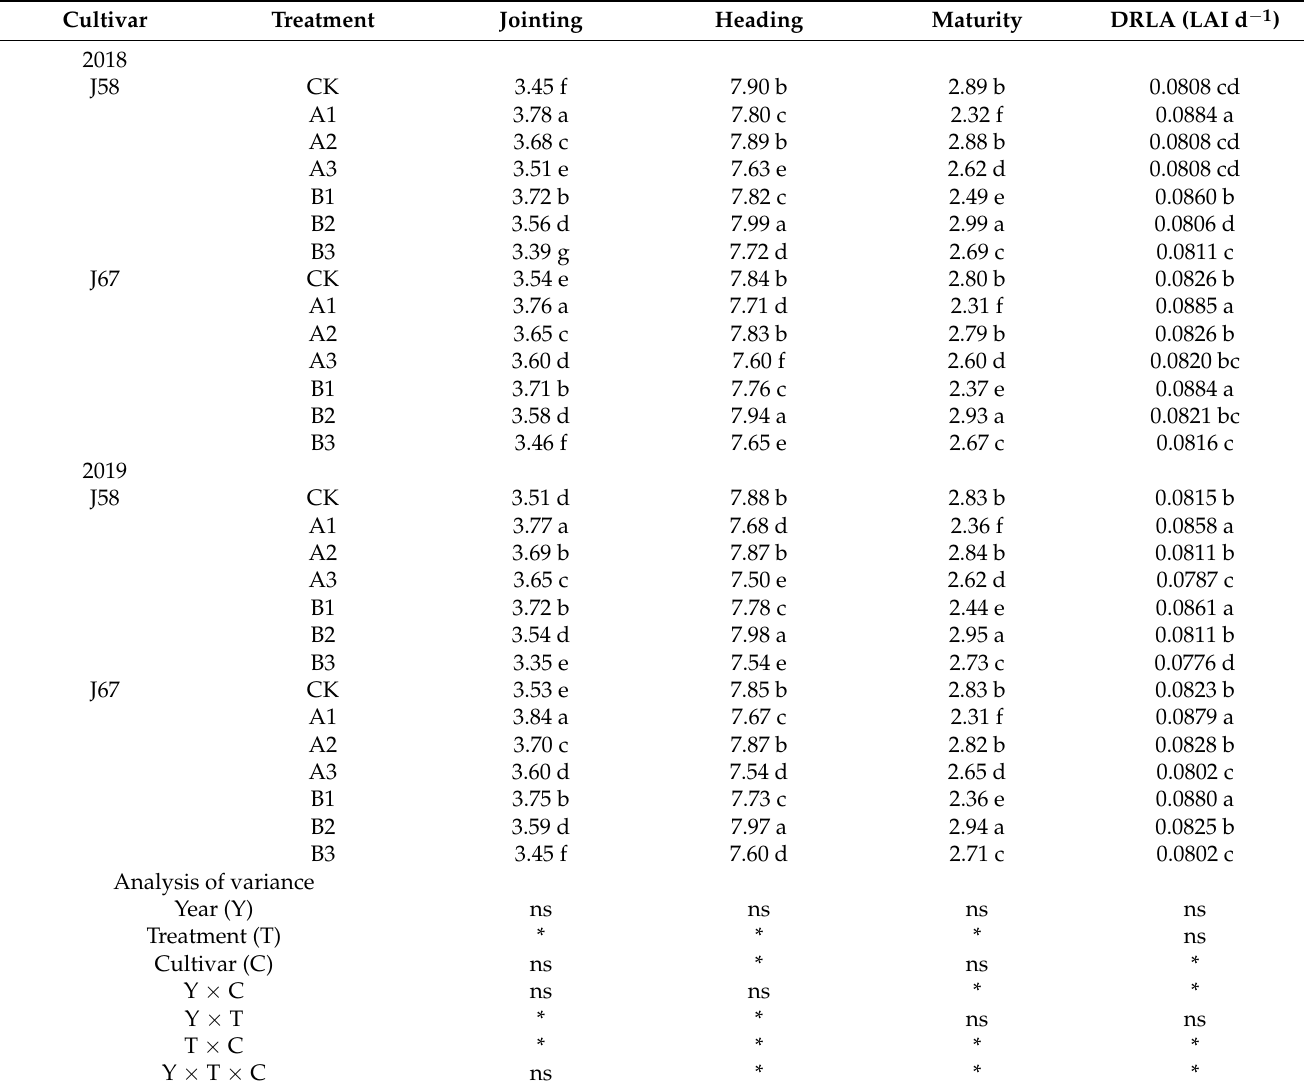
Table 4. Differences in leaf area index of japonica rice 1